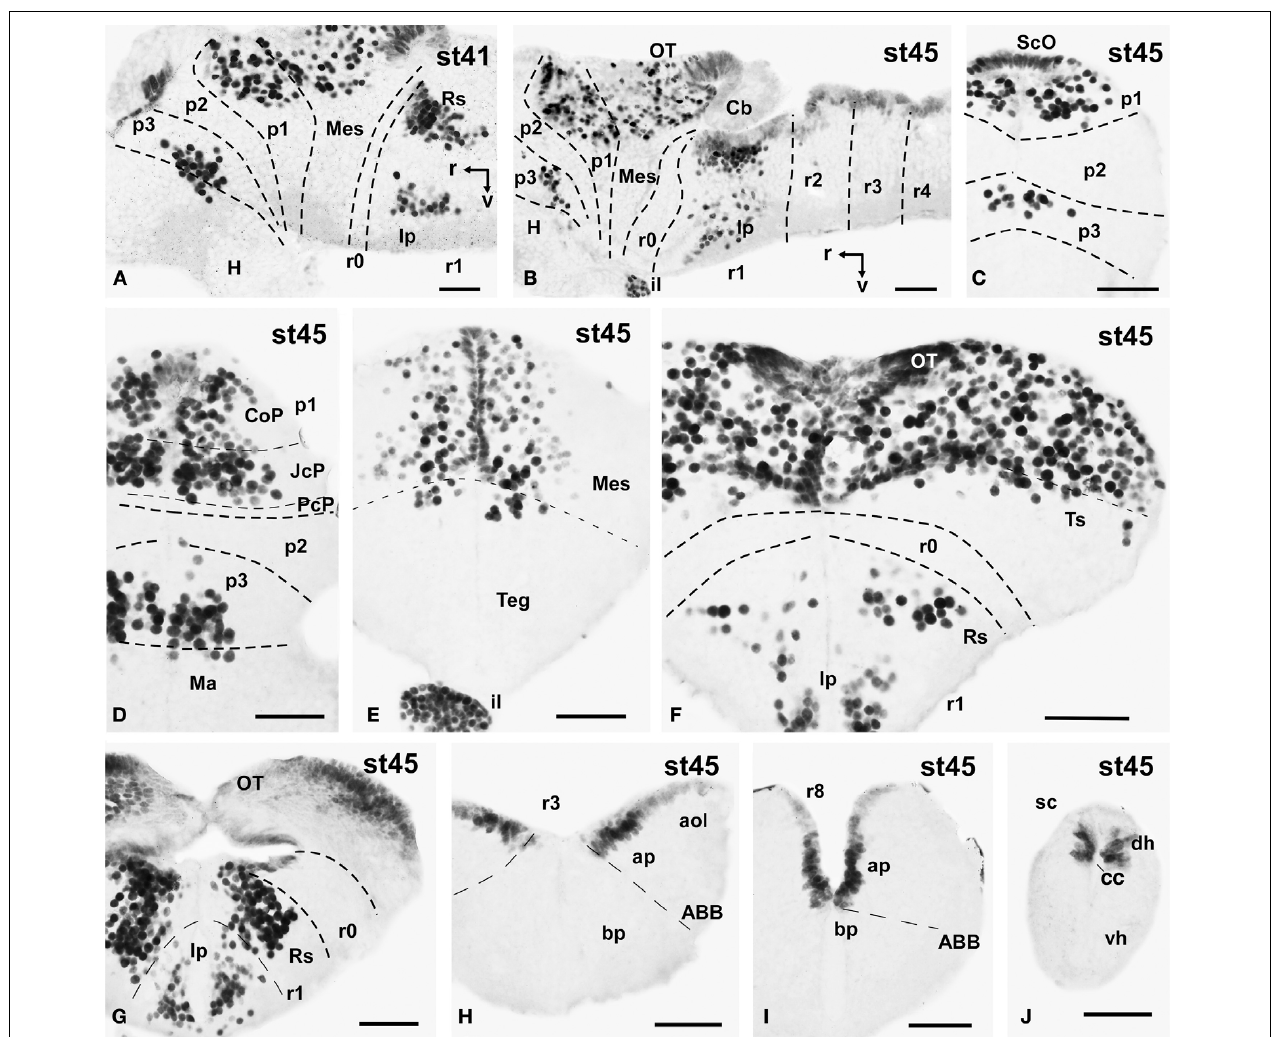
FIGURE 5 | Photomicrographs of single-stained sagittal (A,B) and transverse (C–J) sections through the brain of Xenopus laevis showing the localization of Pax7 cells. Different stages (indicated in the upper right corner of each photomicrograph) corresponding to late embryos are illustrated. All images are oriented following the